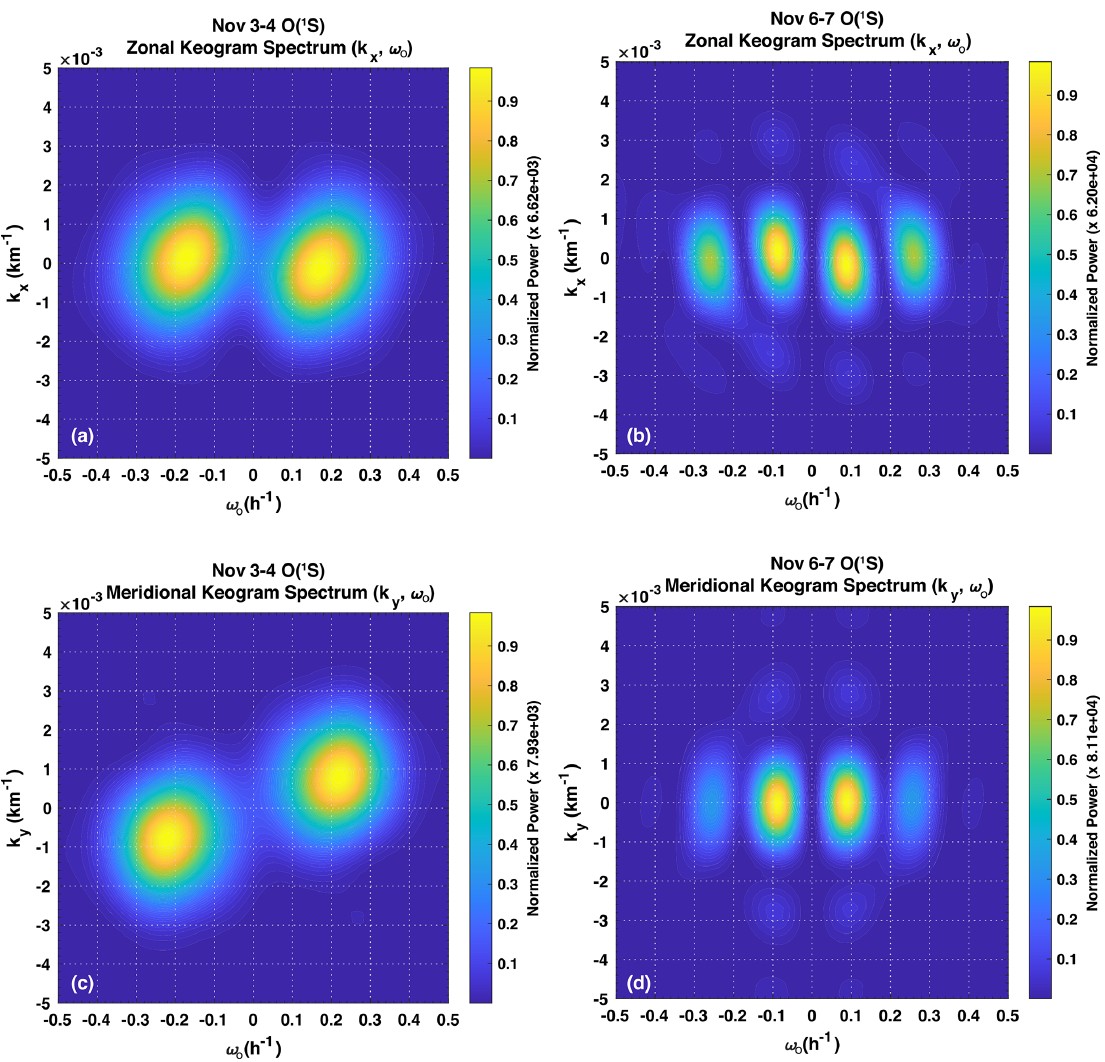
Figure 9. Composite ( k x ,ω o ) and ( k y ,ω o ) spectra of the keograms in Fig. 8 for the nights of 3–4 November (a, c) and 6–7 November (b, d)